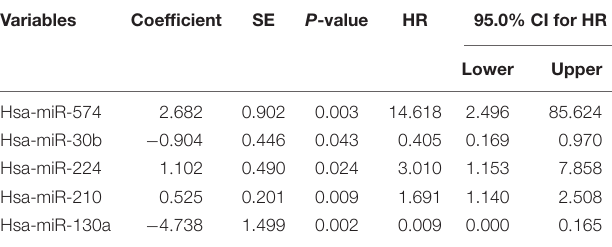
TABLE 2 | Variables in the equation by multivariate Cox regression.